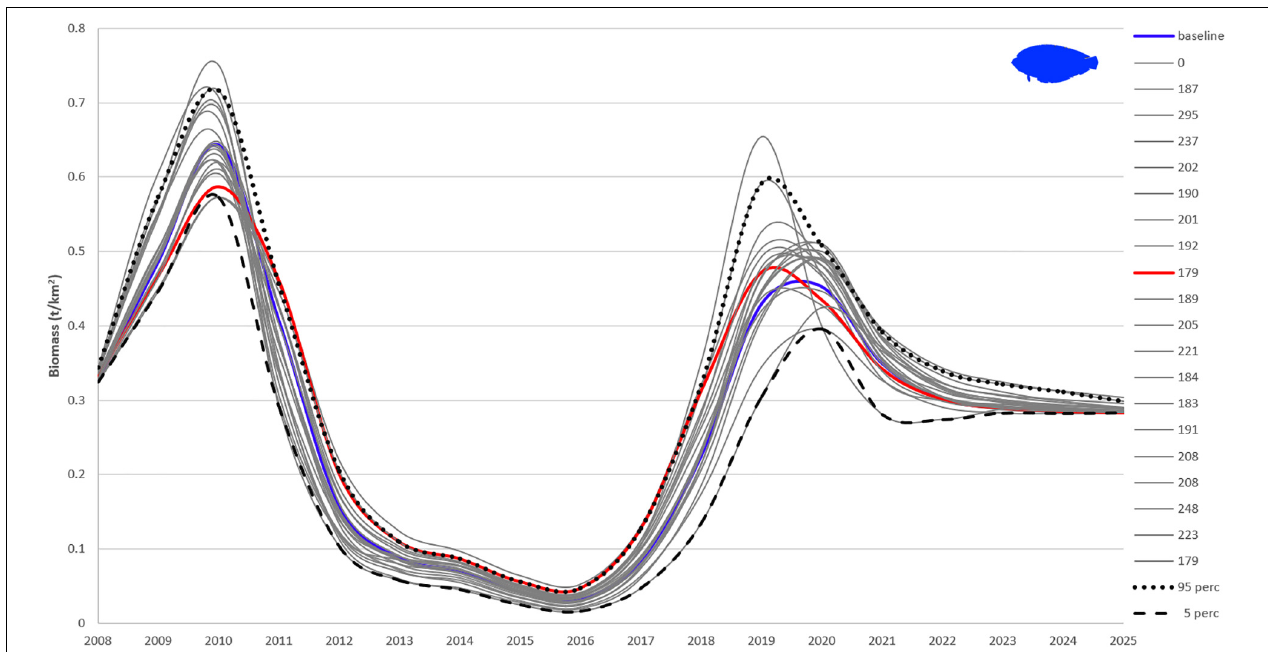
FIGURE 8 | Twenty Monte Carlo simulations of flatfishes biomass with best fitted Pagasitikos model. The blue line (baseline) is the final best fitted model based on the AICc (sum of squares of 172), red line is the model with least sum of squares (179; still higher than the baseline), gray lines are the other 19 fits with legend values representing the final sum of squares for each trial. The 95 and 5% percentile values are also